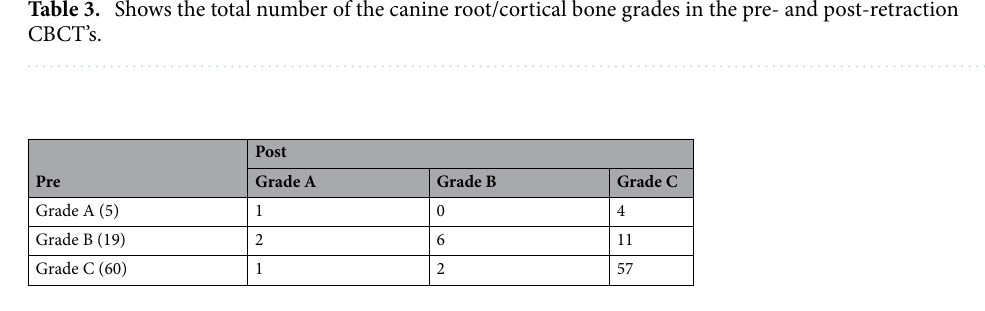
controlling OTM. Hence, the current observational study was conducted to investigate three dimensionally the relationship between the canine root and the labial cortical plate of bone before and after maxillary canine retraction using conventional mechanics. In the current observational study, 42 patients with 84 bilateral maxillary canines were enrolled. The patients’ orthodontic treatment plan necessitated extraction of maxillary first premolars and retraction of maxillary canines. Conventional orthodontic mechanics were applied using NiTi retraction spring delivering a force of 150 g. Three-dimensional CBCT were collected prior to and after canine retraction yielding 168 observations of the canine. The pre-retraction and post-retraction CBCT were superimposed on stable skeletal structures.